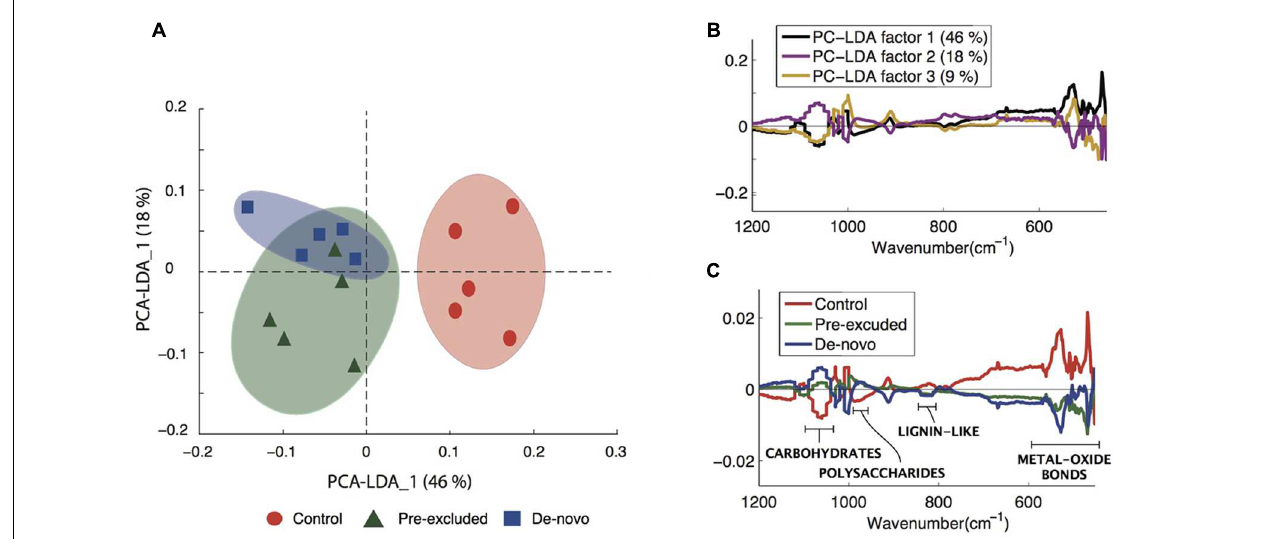
FIGURE 3 | Changes to carbon composition in treatment vs. control soils. (A) principal components analysis (PCA)-linear discriminant analysis (LDA) of the complete Fourier Transform Infrared (FTIR) spectra differentiating control and treatment soils. (B) The first three PCA-LDA loadings of the complete data set in the lower spectral region ( ≤ 1200 cm − 1 ) showing the regions that discriminated across the two axis given in (C) . (C) Infrared spectra depicting the control and treatment soils, the spectral features have been annotated to indicate the different soil compounds relevant to the current study. An extension of this figure with complete annotations is given in the Supplementary Figure